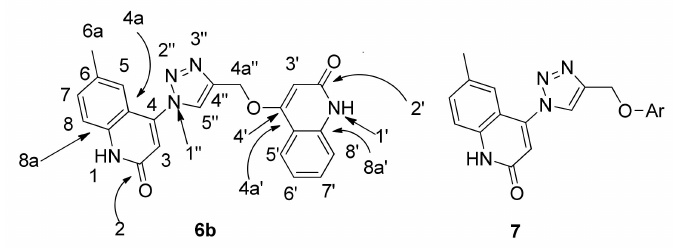
Figure4. 6-methyl-4-(4-(((2-oxo-1,2-dihydroquinolin-4-yl)oxy)methyl)-1 H -1,2,3-triazol-1-yl)quinolin-2(1 H )-one 6b and 7 (Ar = p